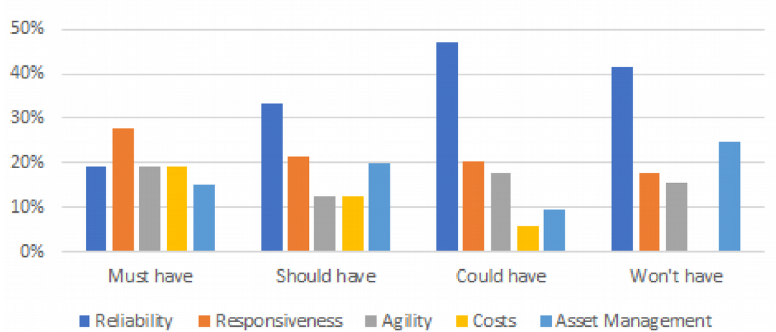
Figure 6. Analysis of prioritised metrics by performance attribute